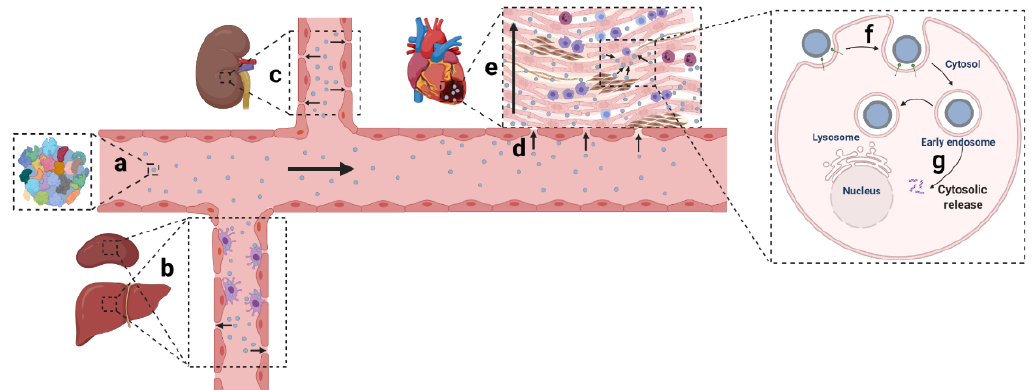
Figure 1. Delivery barriers of nanoparticles targeting an injured heart. ( a ) Formation of protein corona shielding the surface of nanoparticles. ( b ) Sequestration by MPS. ( c ) Filtration through the kidney. ( d ) Extravasation into the cardiac tissue. ( e ) Penetration in the tissue. ( f ) Uptake by cardiac cells. ( g ) Endosomal escape releasing cargos to